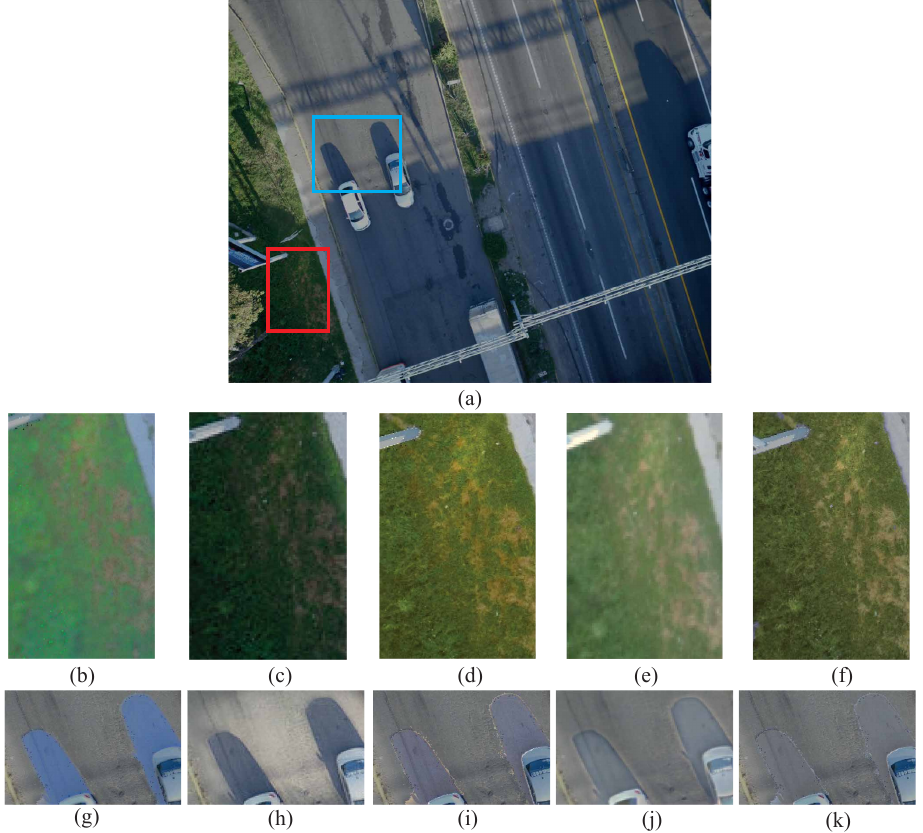
Figure 8. Input image for study case 1 ( a ), close view of the grass area for illumination correction ( b ), SMGAN method ( c ), color transfer method ( d ), SynShadow method ( e ), and the proposed work ( f ). A close view of asphalt color-corrected region for illumination correction ( g ), SMGAN method ( h ), color transfer method ( i ), SynShadow method ( j ), and the proposed work ( k